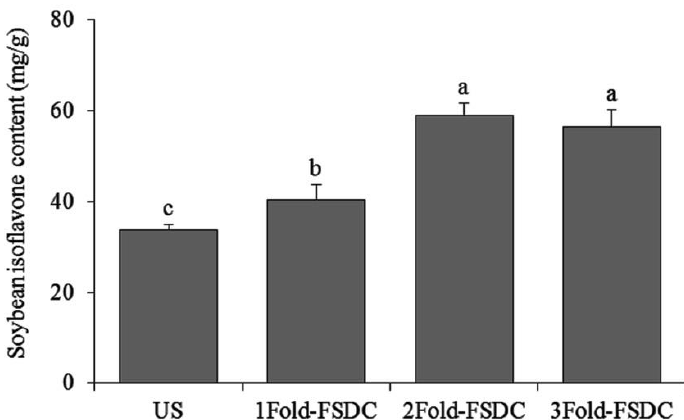
Figure 7. Soybean isoflavone contents of Shuidouchi soaked in different water volumes. a–c Mean values with different letters in the bar are significantly different ( p < 0.05). US: unfermented soybean; 1Fold-FSDC: 1-fold soaking water of soybeans for Shuidouchi fermentation; 2Fold-FSDC: 2-fold soaking water of soybeans for Shuidouchi fermentation; 3Fold-FSDC: 3-fold soaking water of soybeans for Shuidouchi fermentation.